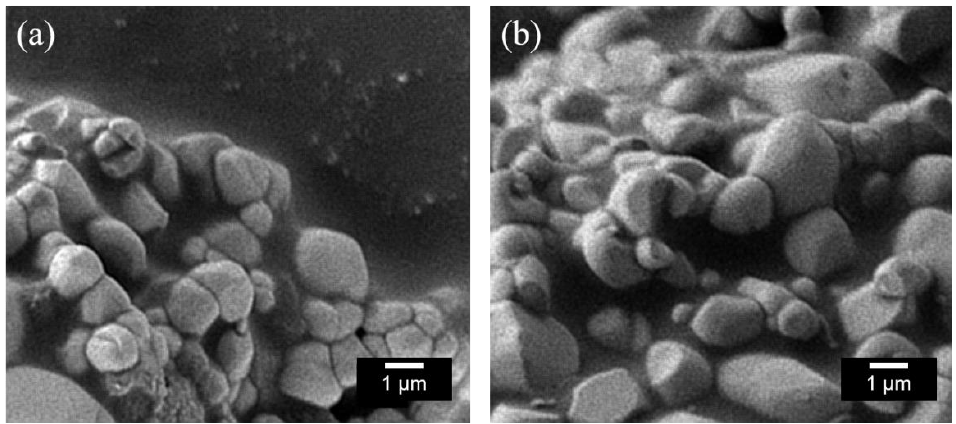
Figure 3. SEM images of ( a ) La 3 LiMnO 7 and ( b ) La 3 LiMn 0.97 Ti 0.03 O 7 .